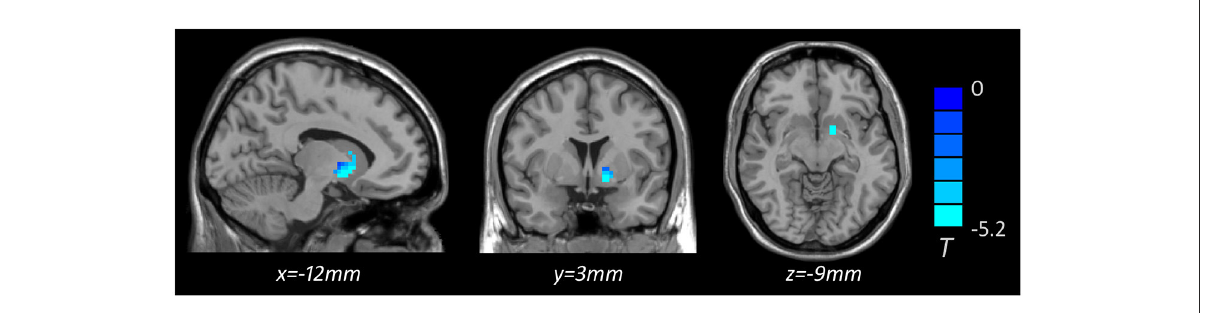
TABLE 4 Brain region showing inter-group differences based on the results of ANOVA ( p < 0.05, GRF corrected ). Brain region Hemisphere Cluster size t value MNI coordinate MDD with anhedonia < HCs Putamen L